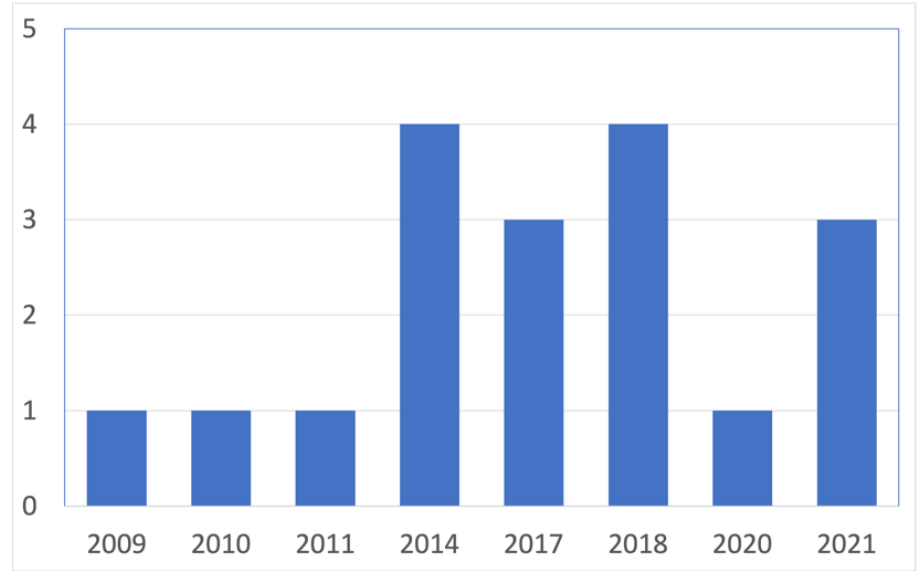
Figure 3. Number of studies in different years.